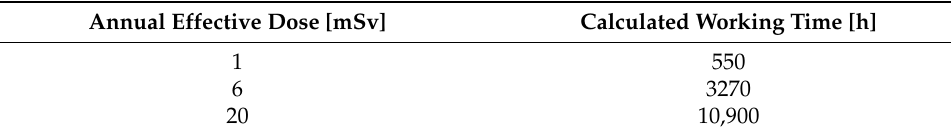
Table 6. Calculated working time for dose